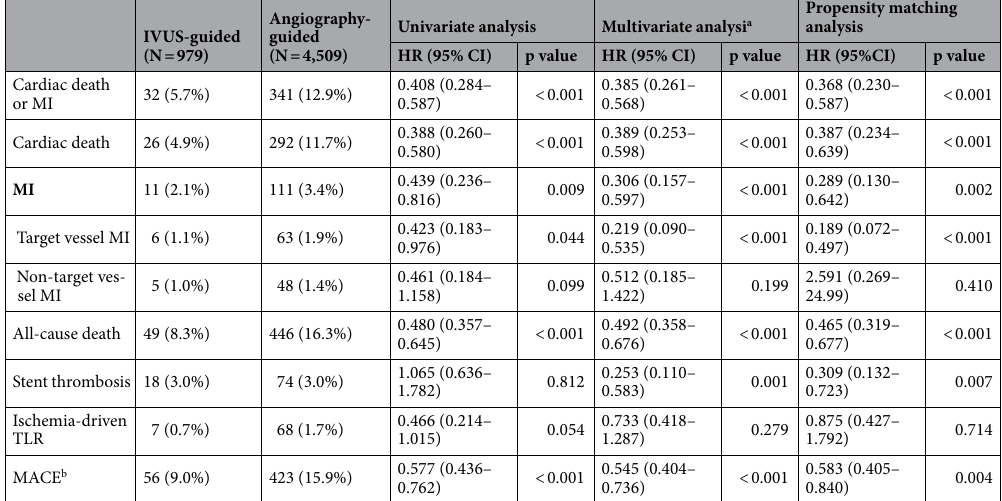
Table 3. Long-term clinical outcomes of IVUS-guided PCI versus angiography-guided PCI. CI, confidence interval; HR, hazard ratio; IVUS, intravascular ultrasound; MACE, major adverse cardiac event; MI, myocardial infarction; PCI, percutaneous coronary intervention; TLR, target-lesion revascularization. a Adjusted variables were age; sex; hypertension; diabetes mellitus; hyperlipidemia; chronic kidney disease; current smoker; previous history of PCI, MI, or cerebrovascular accident; left ventricular ejection fraction; acute coronary syndrome; multivessel disease; left main disease; lesion locations; complex procedure; and medications (aspirin, P2Y12 inhibitor, statin, beta-blocker, and renin-angiotensin receptor blocker). b MACE was defined as: a composite of cardiac death, MI, stent thrombosis, and ischemia driven TLR.